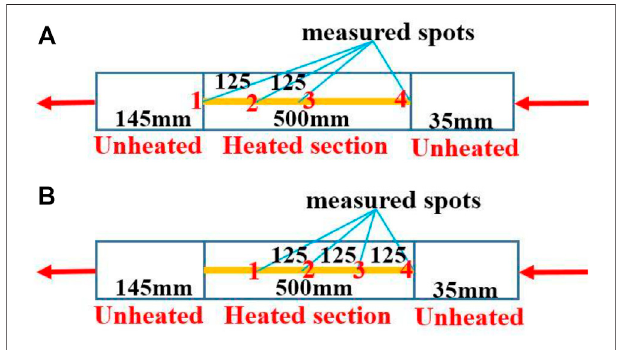
FIGURE 7 | Schematic of the speci fi c structure of measured spots of Type (A,B) .